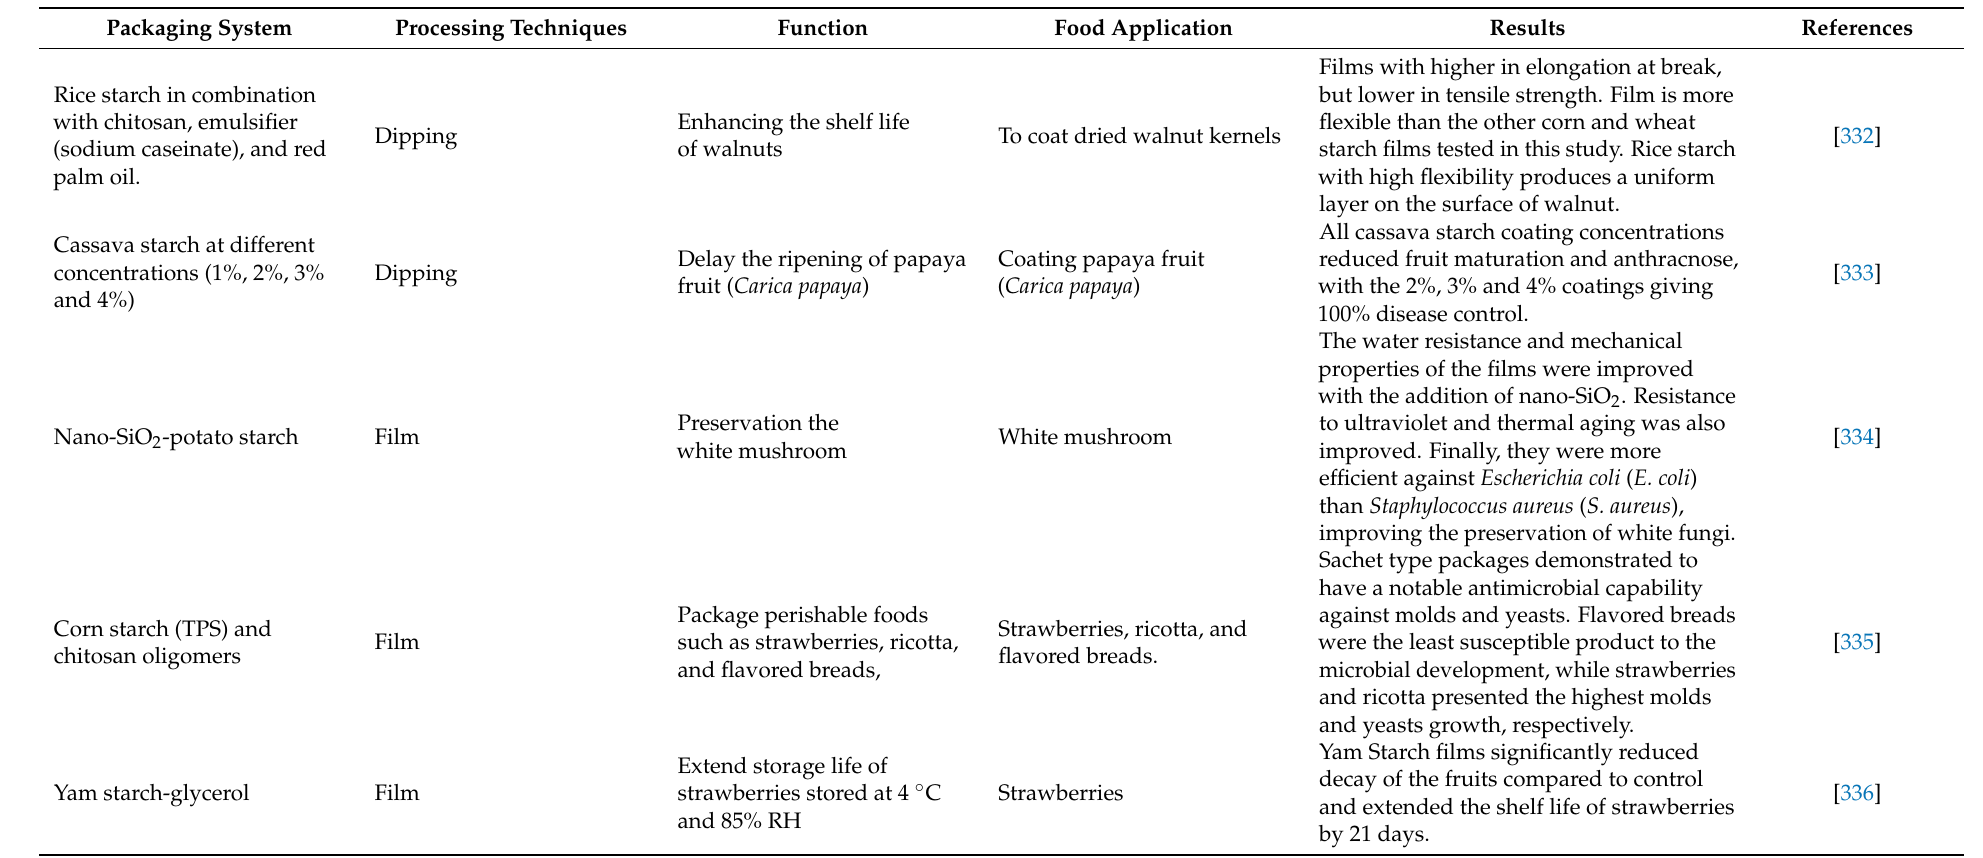
Table 8. Packaging system, food application and mains results of pre-commercial studies of starch based